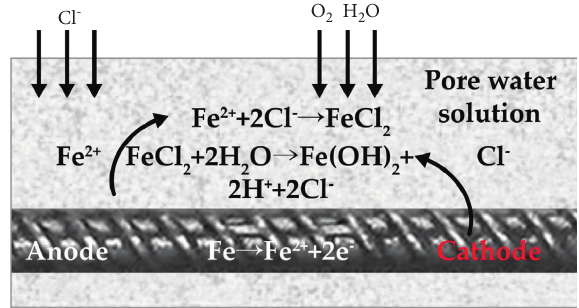
Figure 1: The corrosion mechanism of steel bars